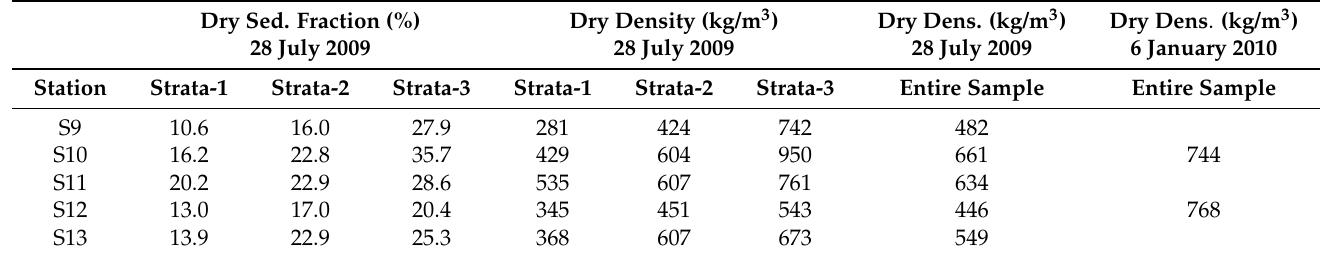
Table 3. Dry sediment properties measured by [2]; sediment fraction and density per strata at stations S9–S13, and dry density of the entire sample core, in summer and winter. Dry Sed. Fraction (%)